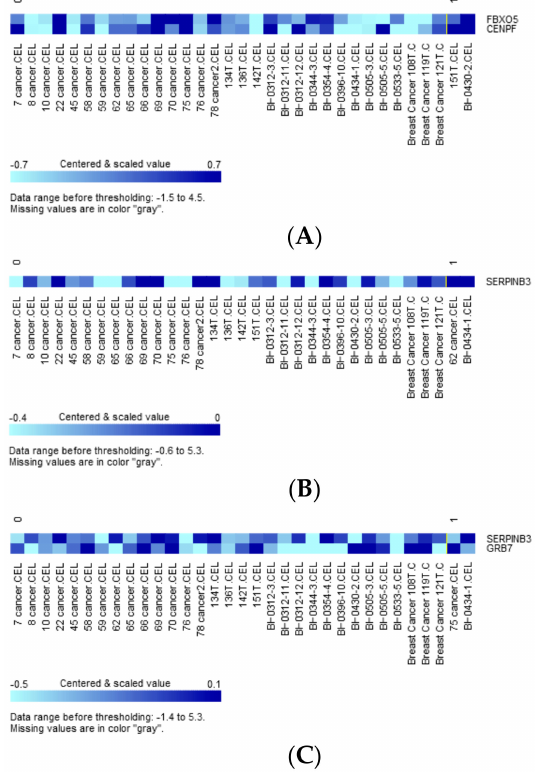
Figure 7. ( A ) Clustered heatmap of differentially expressed genes FBXO5 and CENPF , with samples grouped by class. Class 0: SH3GLB2 wild-type (31 samples), class 1: SH3GLB2 mutant-type (2 samples). ( B ) Clustered heatmap of differentially expressed gene SERPINB3 , with samples grouped by class. Class 0: SH3GLB2 wild-type (31 samples), class 1: SH3GLB2 p.V223M (2 samples). ( C ) Clus- tered heatmap of differentially expressed genes SERPINB3 and GRB7 , with samples grouped by class. Class 0: ERBB2 wild-type (31 samples), class 1: ERBB2 p.P107L (2